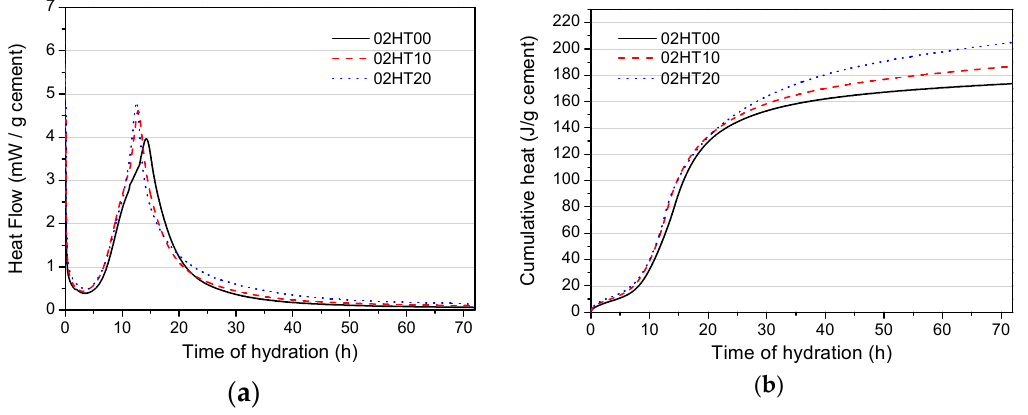
Figure 7. Hydration heat evolution of samples with w/b = 0.2. ( a ) Heat evolution rate. ( b ) Cumulative heat.